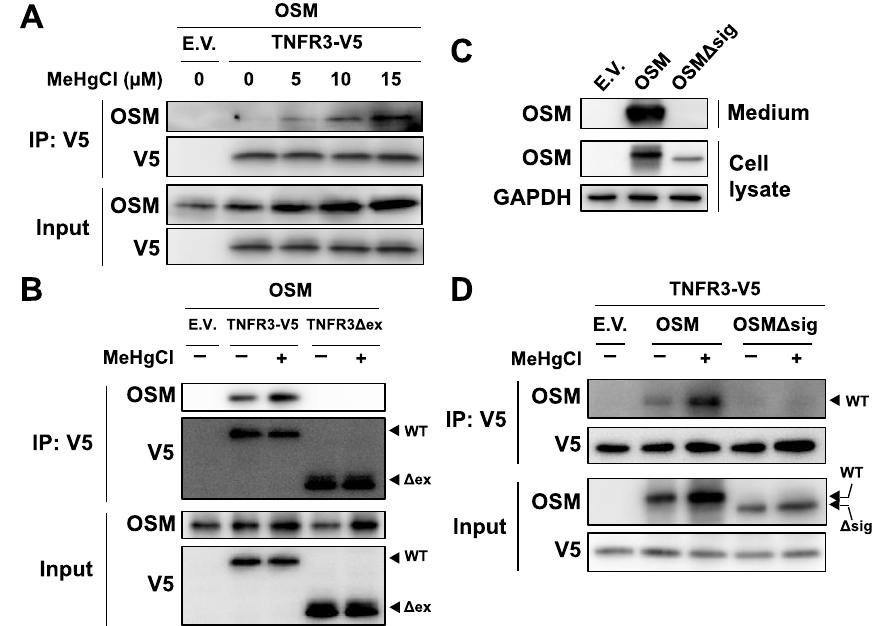
Figure 6. E ff ects of methylmercury on the binding between OSM and TNFR3. ( A ) HEK293 cells were transfected with TNFR3-V5- and/or OSM-expressing plasmids for 24 h and were exposed to methylmercuric chloride (MeHgCl) for 6 h. Cell lysates were subjected to immunoprecipitation (IP) by an antibody against V5-tag, and immunoblotting for OSM and V5 was performed. E.V. indicates an empty vector. ( B ) Cells were transfected with TNFR3- or TNFR3 ∆ ex- (deletion mutant of extracellular domain) and OSM-expressing plasmids for 24 h. Cells were exposed to MeHgCl (15 µ M) for 6 h. IP by V5-tag was performed. ( C ) Cells were transfected with OSM- or OSM ∆ sig- (deletion mutant of the signal peptide required for extracellular release) expressing plasmids for 24 h. The incubation medium and cell lysates were subjected to immunoblotting for OSM. GAPDH was used as an internal control for cell lysates. ( D ) Cells were transfected with TNFR3- and OSM- or OSM ∆ sig-expressing plasmids for 24 h. IP by V5-tag was